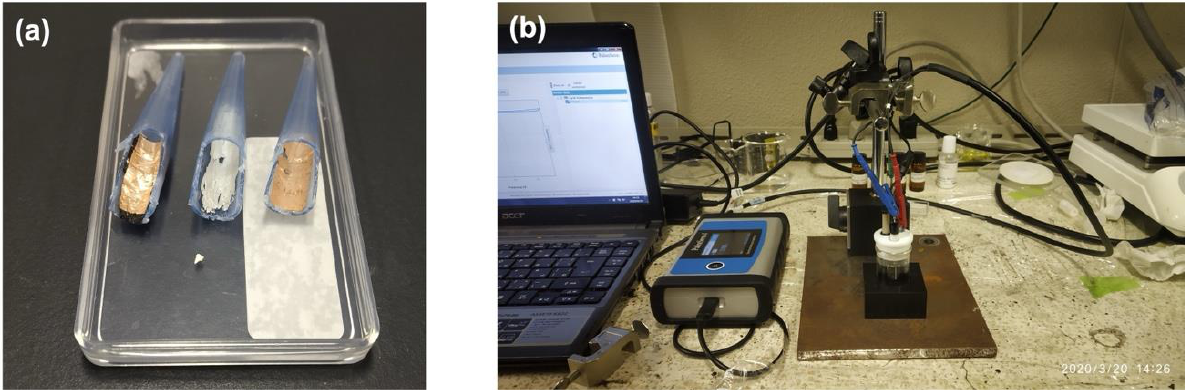
Figure 2. ( a ) Image of the support tip that was cut longitudinally and cross-sectionally, followed by pasting carbon and copper tapes as conductive ends. ( b ) Image showing the electrochemical cell set up for analysis, with the modified tip placed in the support tip.